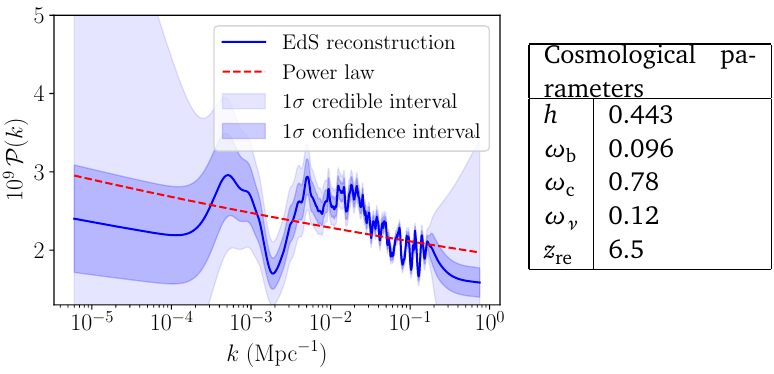
Figure 8: The estimated PPS for the EdS cosmological model with neutrino dark matter from Planck Release 2 T T , T E and EE data. The left panel shows the recon- structed PPS (blue line) with credible (purple band) and confidence intervals (light = 0.968 power-law PPS (red dashed line) superimposed. The blue band) with n s right panel shows the cosmological parameters.